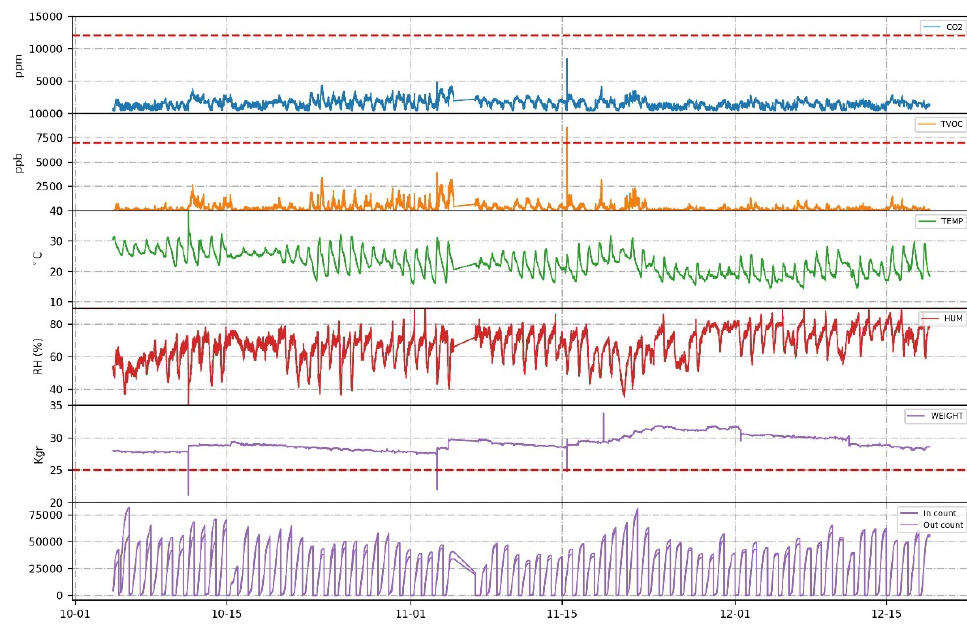
forecasts due to complementarity of informational Figure 4. A part of the multivariable time series. Forming sensory data this way allows better fore- casts due to complementarity of informational queues.